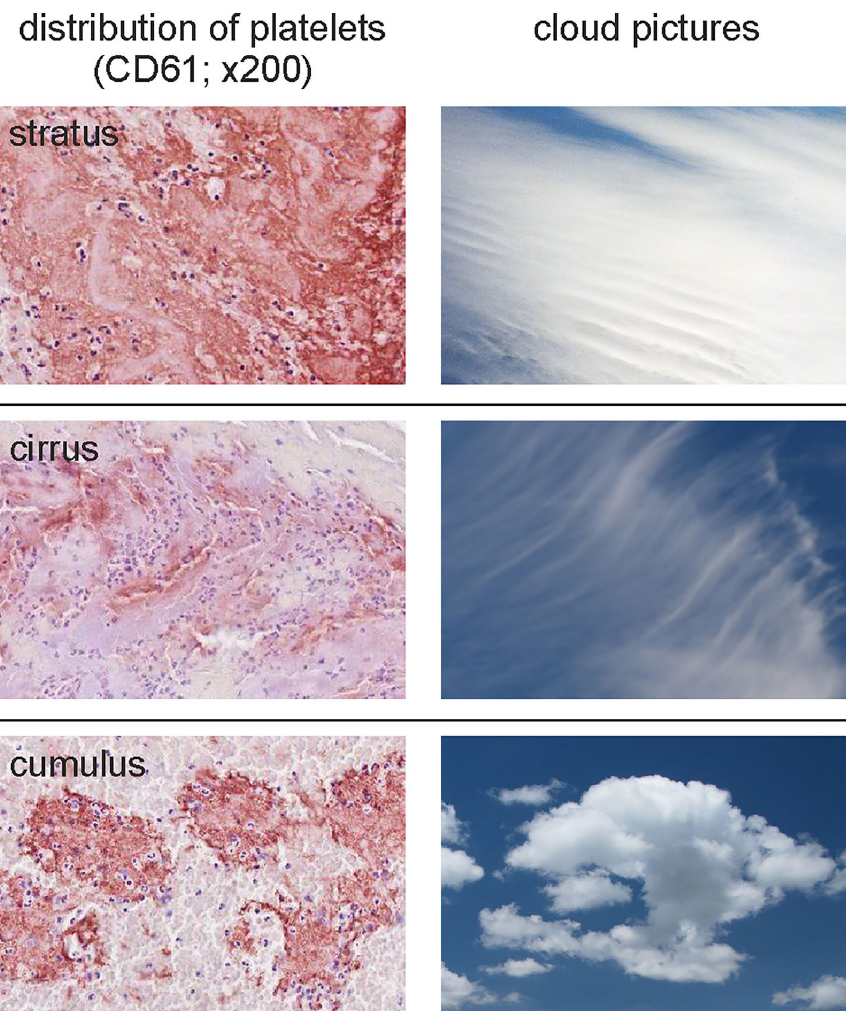
Figure 2. Description of different platelet distributions used by the THROMBEX clot classification. In analogy to basic meteorological cloud shapes (right side) used by the World Meteorological Organization published in the International Cloud Atlas 30 we described platelet distribution within clots (left side) as “stratus”, “cirrus”, and “cumulus”. Following the wording of the International Cloud Atlas, in a stratus distribution platelets occur as a merged layer with a uniform appearance or in the form of ragged patches. A cirrus distribution is characterized by detached clusters in the form of delicate filaments or narrow bands, having a hair-like appearance. Cumulus- like arranged platelets appear as detached and dense clusters with sharp outlines. They may be in the form of domes or towers. Sometimes they are ragged. (Prof. Stephan Borrmann of the Institute of Atmospheric Physics at the Johannes Gutenberg University of Mainz, Germany kindly provided the used cloud